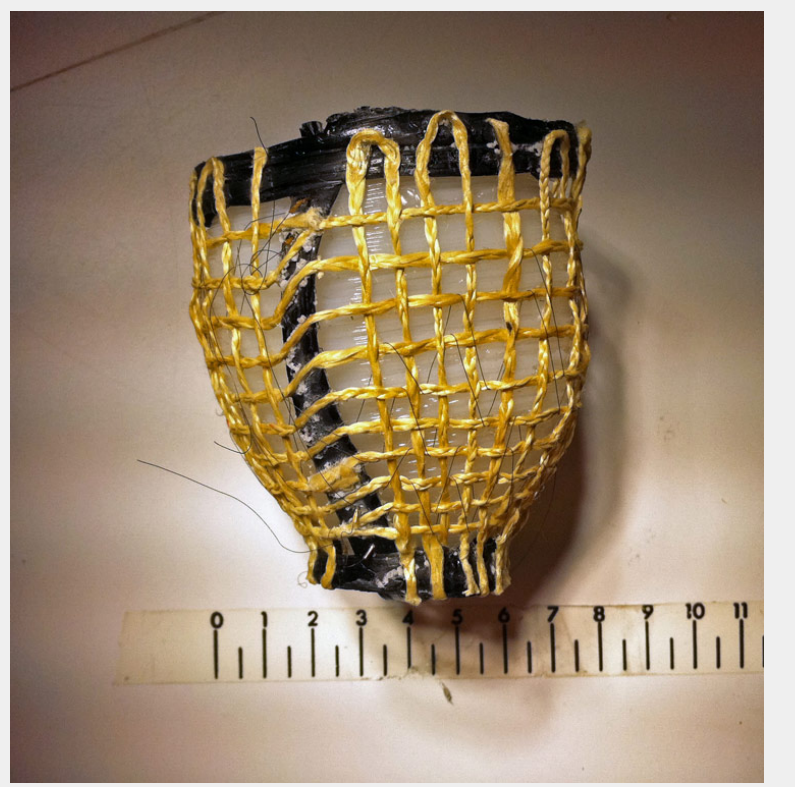
The external bi-ventricular assist device comprises a skeleton of carbon fibre (black bands) and a mesh (yellow) of aramidic fibres. The carbon fibre follows the interventricular septum, the atrio-ventricular groove, and encircles the cardiac apex. Zig-zagging through the aramidic tissue are interwoven nitinol fibres, which are joined to the carbon skeleton at the apex of the heart and then spiral around the ventricles to the atrio- ventricular groove level.